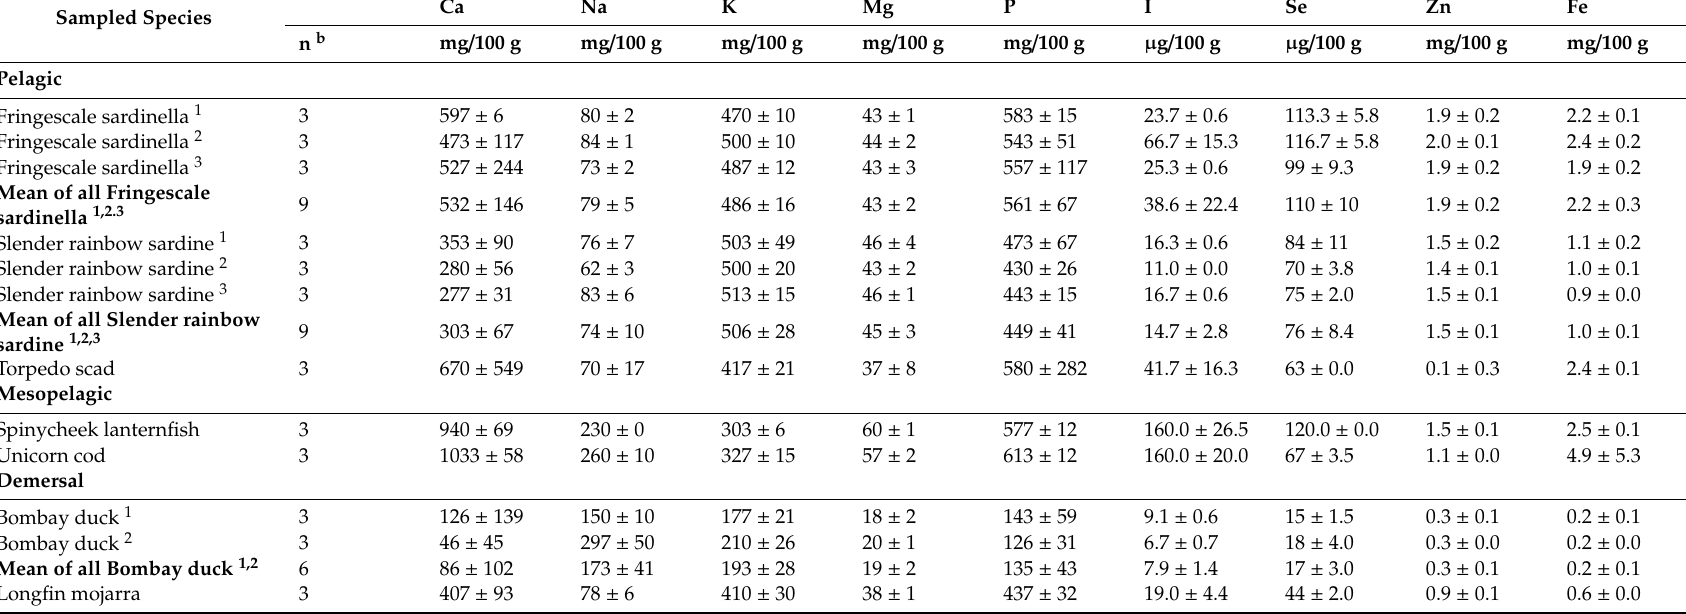
Table 4. Analytical values of the content of minerals and trace elements in the species sampled from Bangladesh a